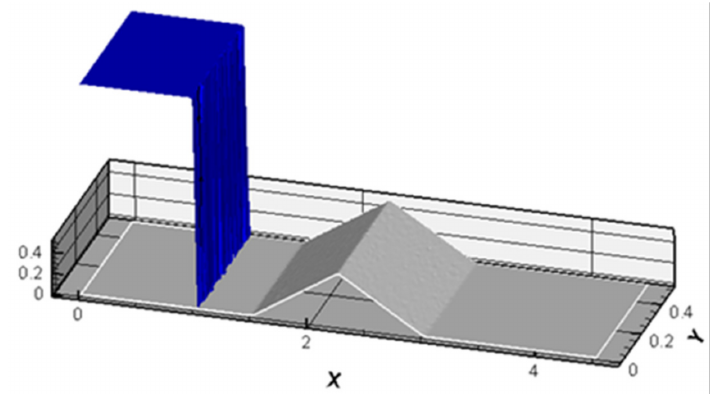
Figure 9. Initial conditions in the test of flow passing barrier and stability above the barrier level.